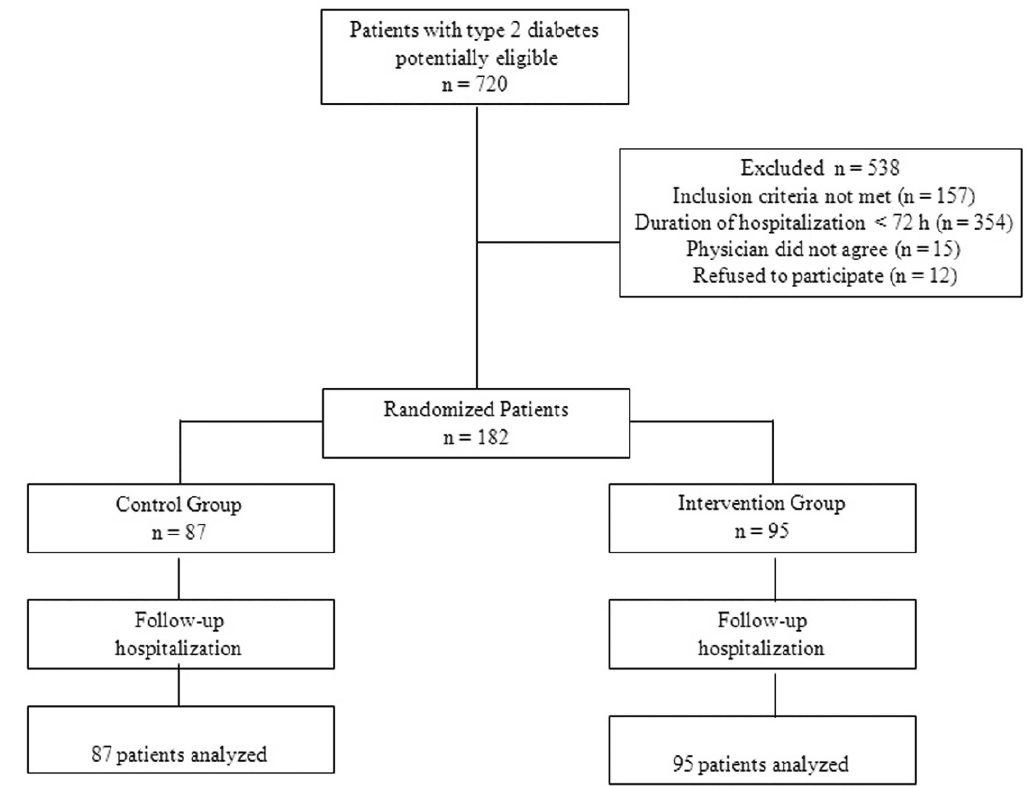
Figure 2 - Flow chart of patient